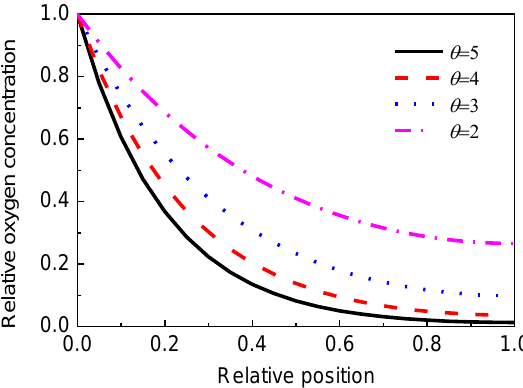
Figure 9. Computed profile of relative oxygen concentration with different.